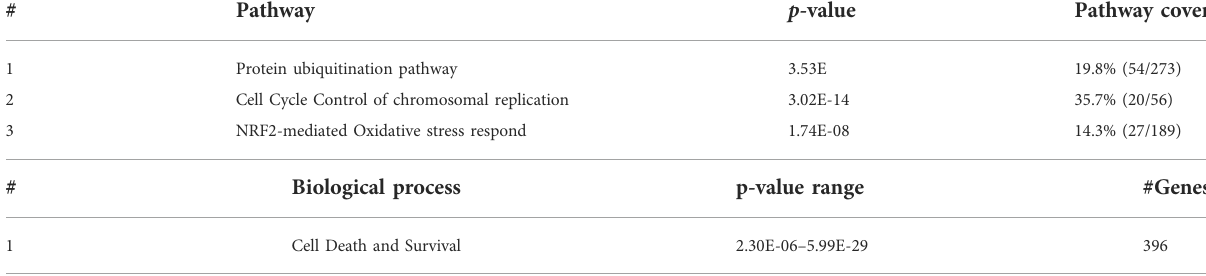
TABLE 7 IPA top enriched pathways and biological processes in gne KO versus gne WT at 7 dpf.